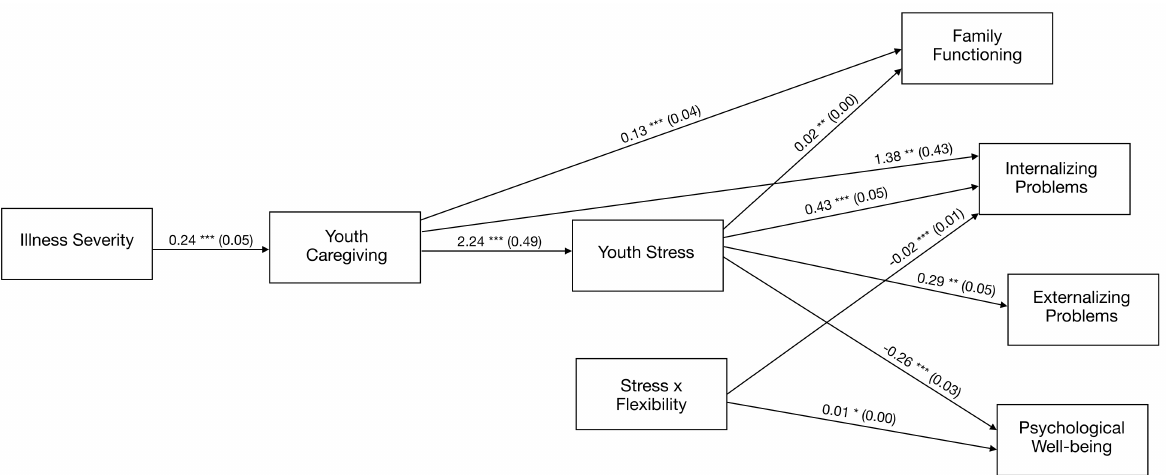
Figure 2. Unstandardized regression coefficients (standard errors) of the moderated mediation or conditional process path analyses depicting the buffering effects of psychological flexibility on youth caregiving and stress. Note. Youth stress and psychological flexibility were mean centered. * p < 0.05, ** p < 0.01, *** p <